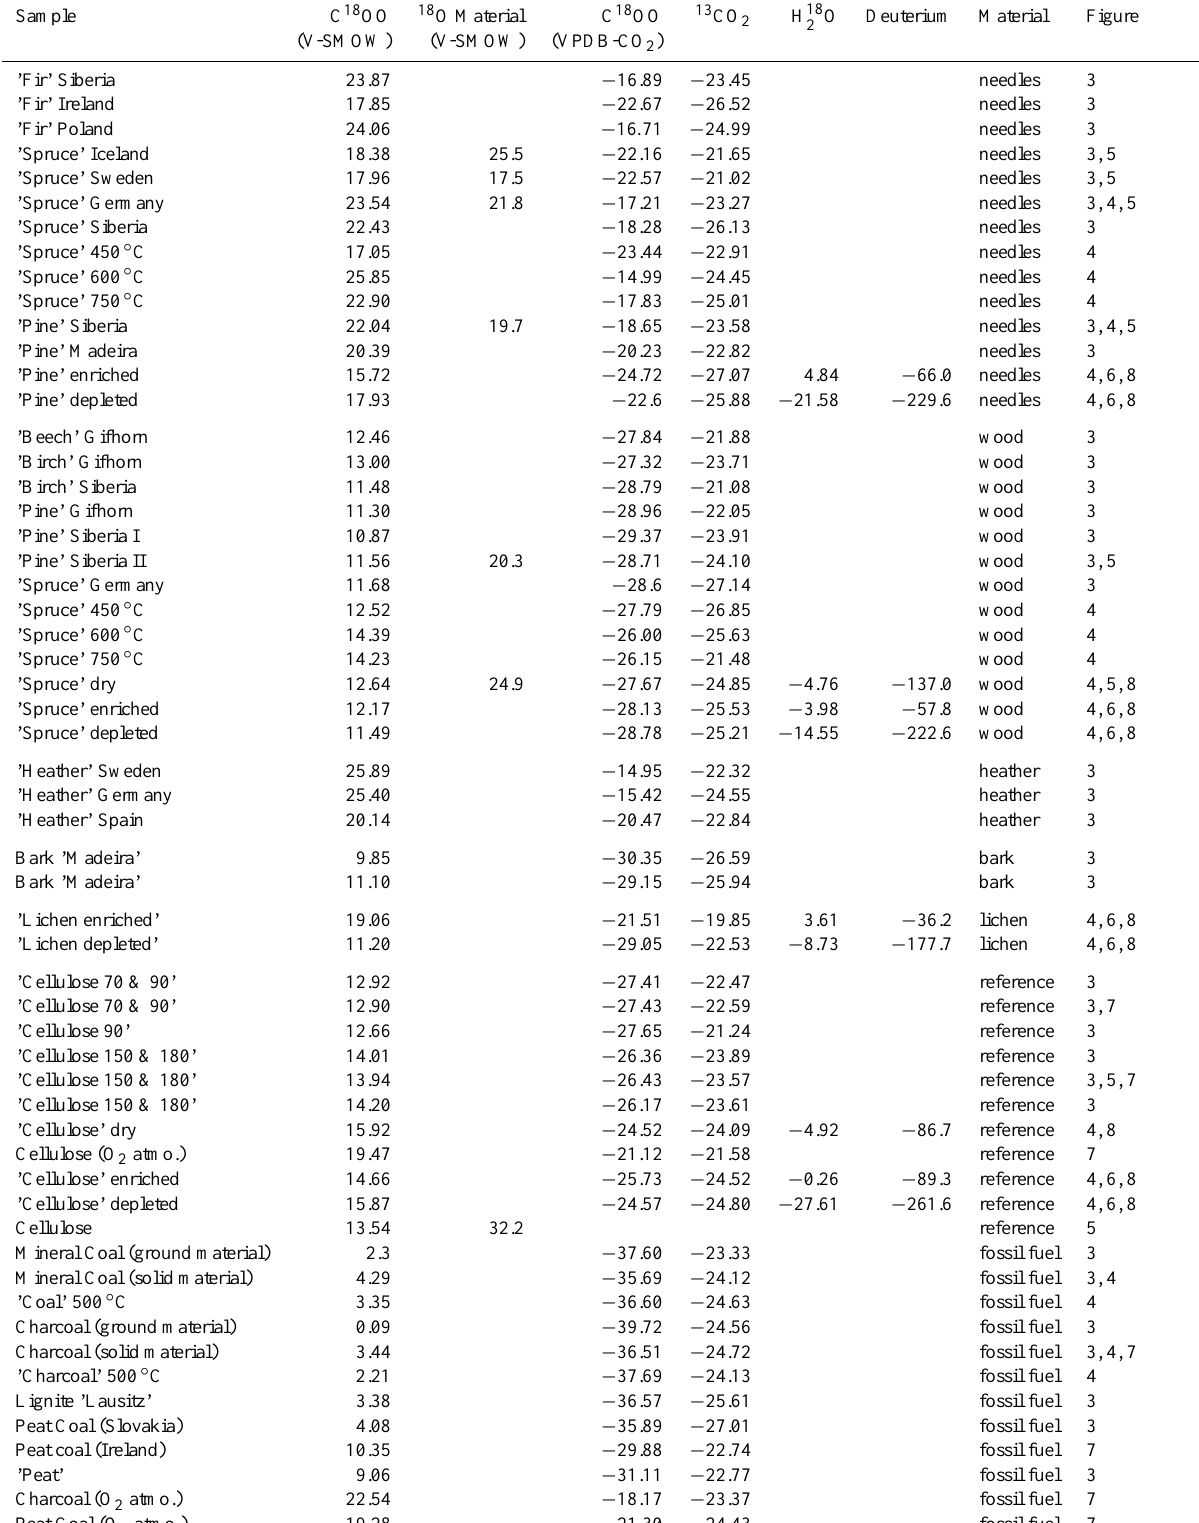
Table 3. Isotopic values of fuel material, combustion derived CO 2 and H 2 O, source oxygen, source water and precipitation from measure- ment sites close to the geographical origin of selected fuel